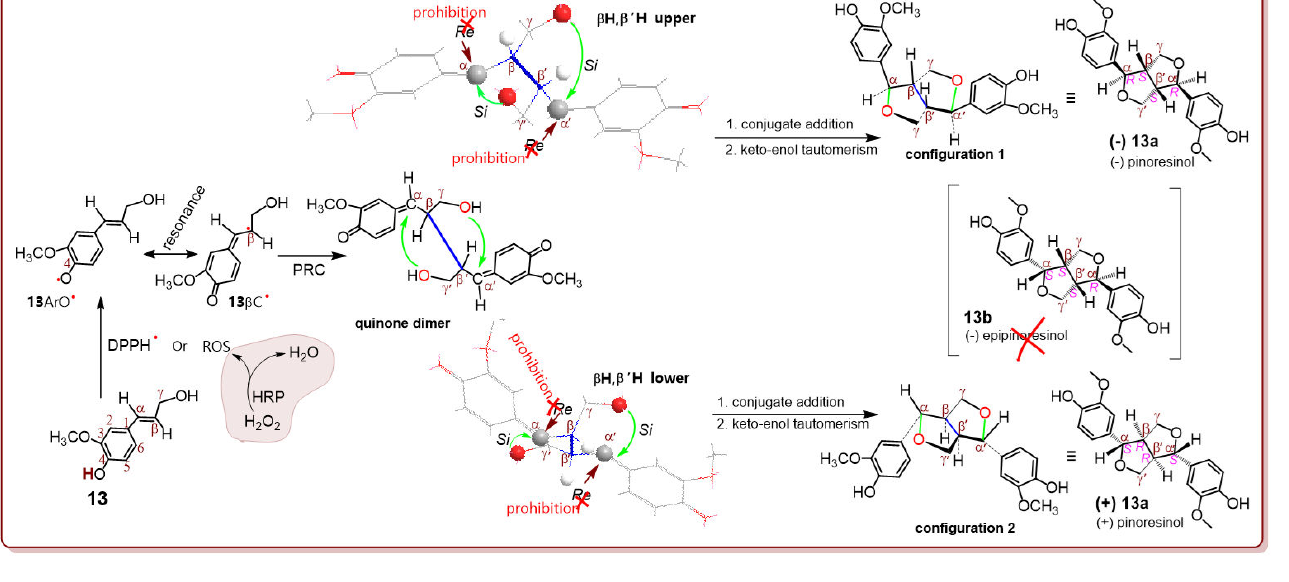
Figure 3. The proposed process and stereochemistry of the conversion of 13 into ( − ) 13a mediated by horseradish peroxidase (HRP)/H 2 O 2 or DPPH • radical. The blue line indicates the β , β (cid:48) covalent bond stemming from the basic phytophenol dimerization